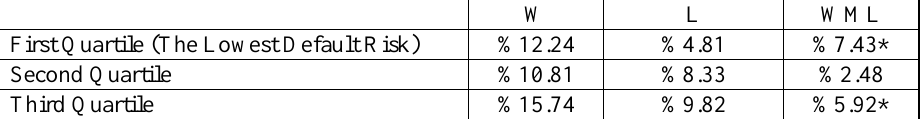
Table (3): Momentum in the Sorted Groups based on Default Risk W L WML First Quartile (The Lowest Default